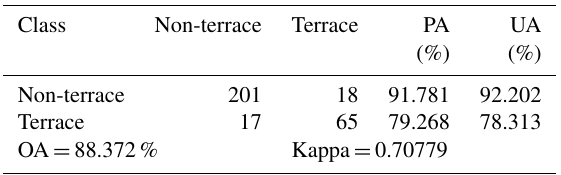
Table 4. Accuracy assessment of the 30m terrace map by the 301 test samples of known